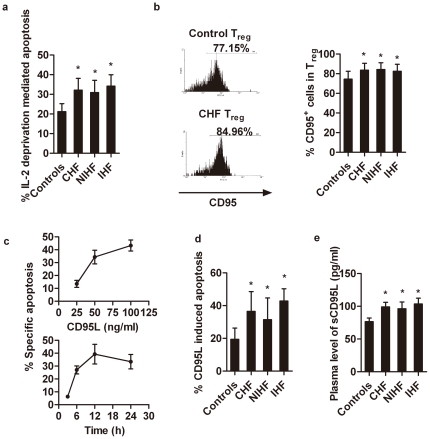
IL-2 deprivation and FasL-mediated Treg-cell apoptosis.PBMCs were stained with anti-CD4, anti-CD25, anti-CD127, and apoptosis was induced as described in Methods. a. IL-2 deprivation-mediated Treg-cell apoptosis between CHF patients (n = 47) and non-CHF controls (n = 38).b. CD95 expression on gated Treg cells from CHF patients (n = 47) and non-CHF controls (n = 38). c. CD95L induced a dose-dependent apoptosis of Treg cells from CHF patients after incubation with CD95L for 12 h (upper panel; data are means from three separate experiments). Apoptosis of Treg cells from CHF patients in the presence of 100 ng/ml CD95L was plotted against time (lower panel; data are means from three separate experiments). d. FasL-induced apoptosis of Treg cells from CHF patients and non-CHF controls (100 ng/ml FasL for 12 hrs). e. ELISA determination of plasma soluble FasL levels in 47 CHF patients and 38 non-CHF controls. *p<0.05 vs. non-CHF controls.